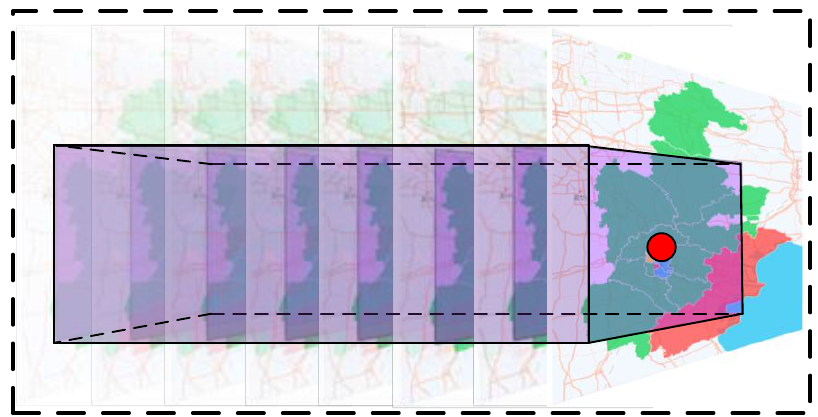
Figure 6. MODL-PLAIN spatial information integration scope. Different administrative areas in each map are painted in different colors according to the observed temperature.